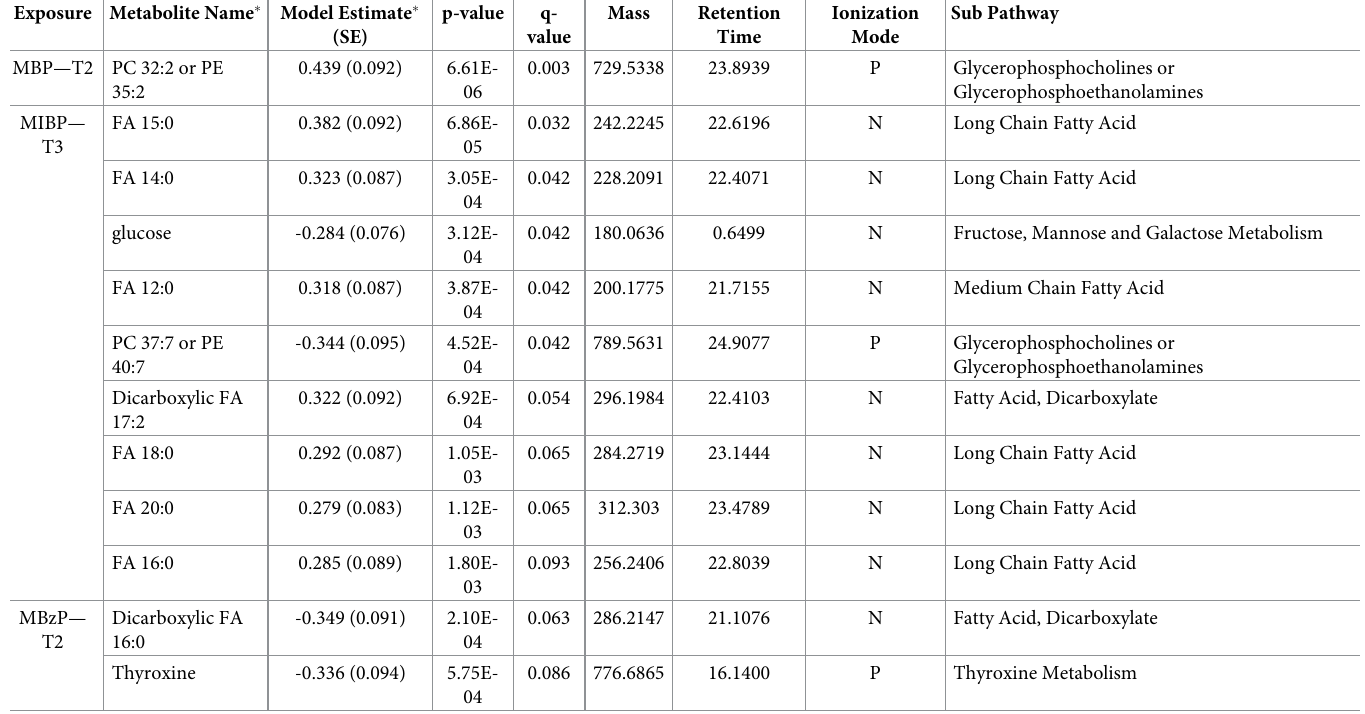
Table 4. Significant associations (q < 0.1) between maternal trimester-specific phthalates and metabolites among 110 boys. Exposure Metabolite Name � Model Estimate �